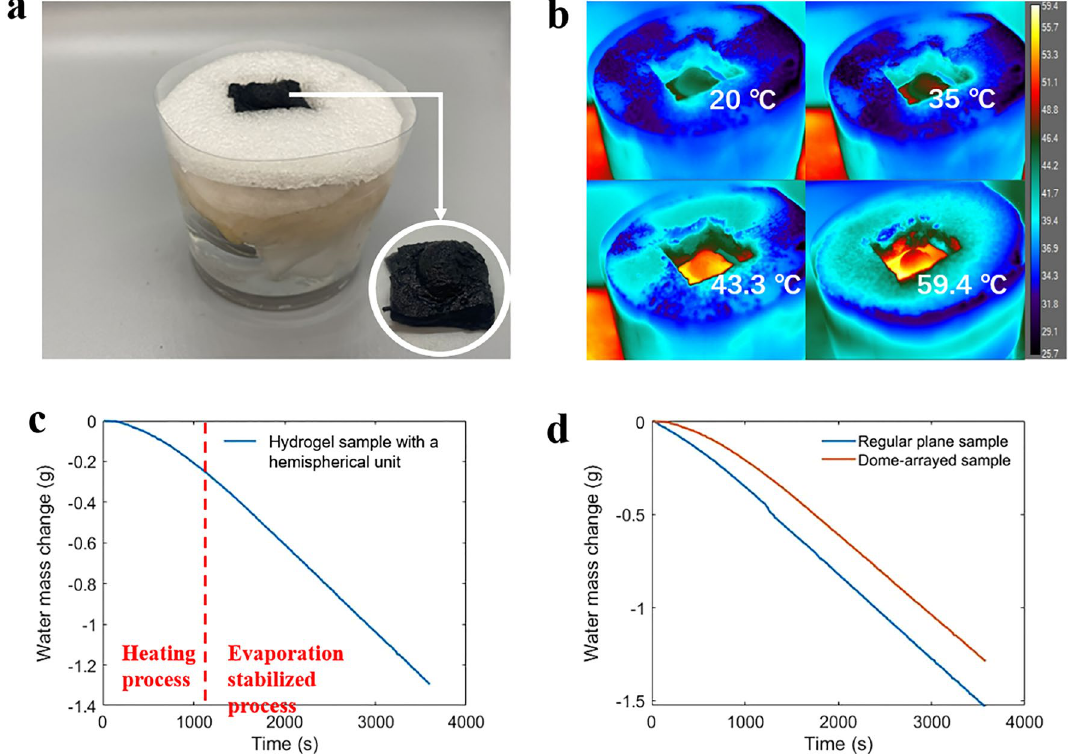
Figure 6. ( a ) Evaporation system with a unit of hemispherical hydrogel sample and the testing unit of hemispherical hydrogel. ( b ) Infrared thermal images of the top surface of hemispherical hydrogel sample during the heating process. ( c ) Water mass change in the system under one sun illumination intensity. ( d ) Water mass changes with dome-arrayed hydrogel sample and with regular plane sample under one sun